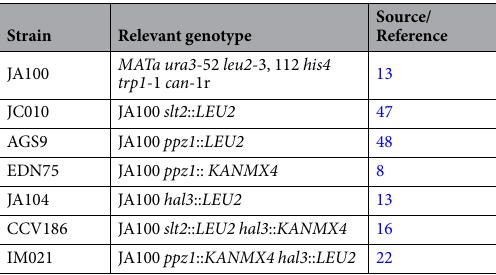
Source/ Reference